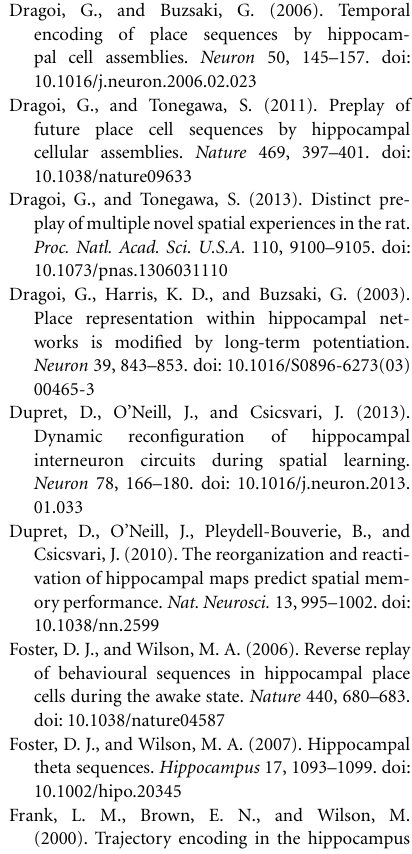
rectangle in the middle matches the one during the ripple in (A) and the place cell sequence on the Top panel. Bottom, phase precession of place cell N3. (C) Replay of the place cell sequence (N1–N5) during a ripple event occurring during the sleep/rest following the run in (B) . The temporal sequences (n1–n5) in (A) and (C) perfectly matching the spatial sequences (N1–N5) in (B) occur in a subset of pre/replay events. Overall, pre/replay sequences are significantly correlated with the place cell sequences to an average absolute correlation value of ∼ 0.75. Time scale bar in (B) also applies to (A) and (C) . All spikes (A–C) and their relation to theta oscillation and ripples are illustrations. Ripple and theta oscillation examples are adapted from experimental